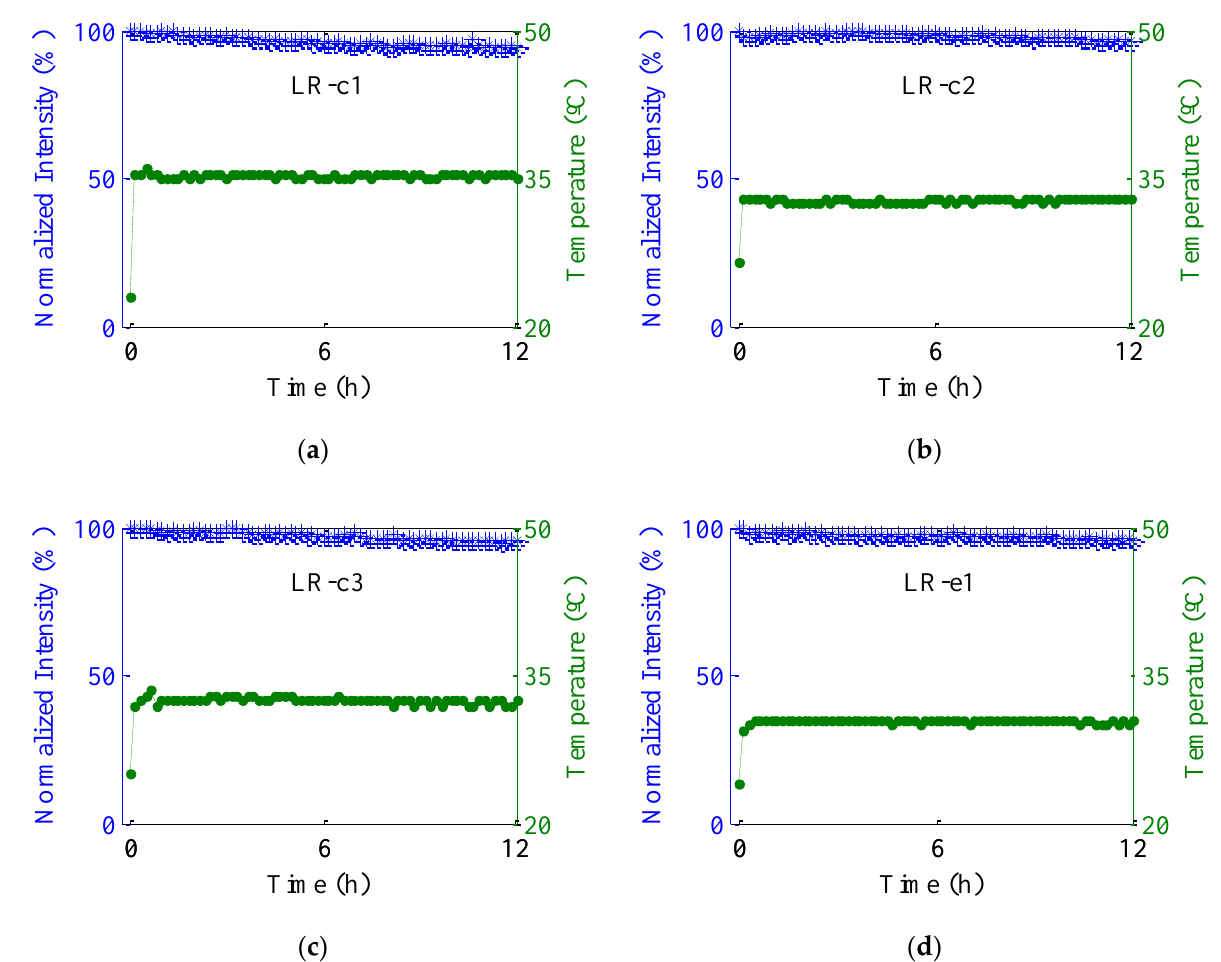
Figure 8. Normalized output intensity (blue crosses) and temperature (green circles) as a function of the sun-simulator exposition time for ( a ) LR-c1, ( b ) LR-c2, ( c ) LR-c3 and ( d ) LR-e1 samples. The green dashed lines of temperature data are guides to the eye.